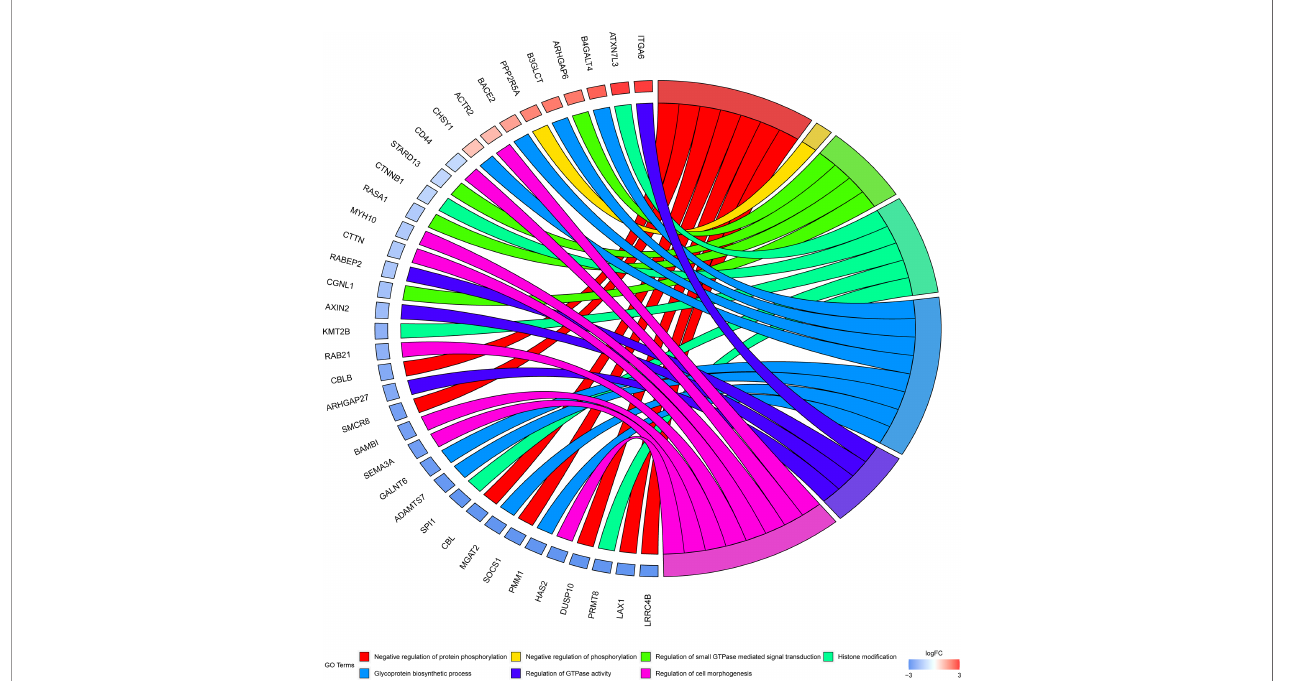
FIGURE 3 | GO terms enrichment analyses of differently methylated genes between in tumor and normal. Squares in the left semicircle refer to the differently methylated mRNAs, and the squares in the right semicircle refer to the GO terms. Fold change ≥ 2 and P -value < 0.05, genes compared to GO